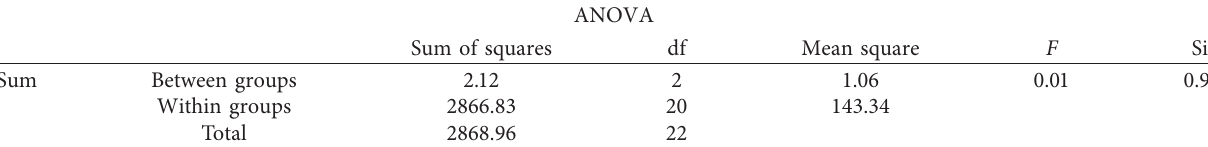
Table 7: ANOVA results for students’ responses based on the study level.